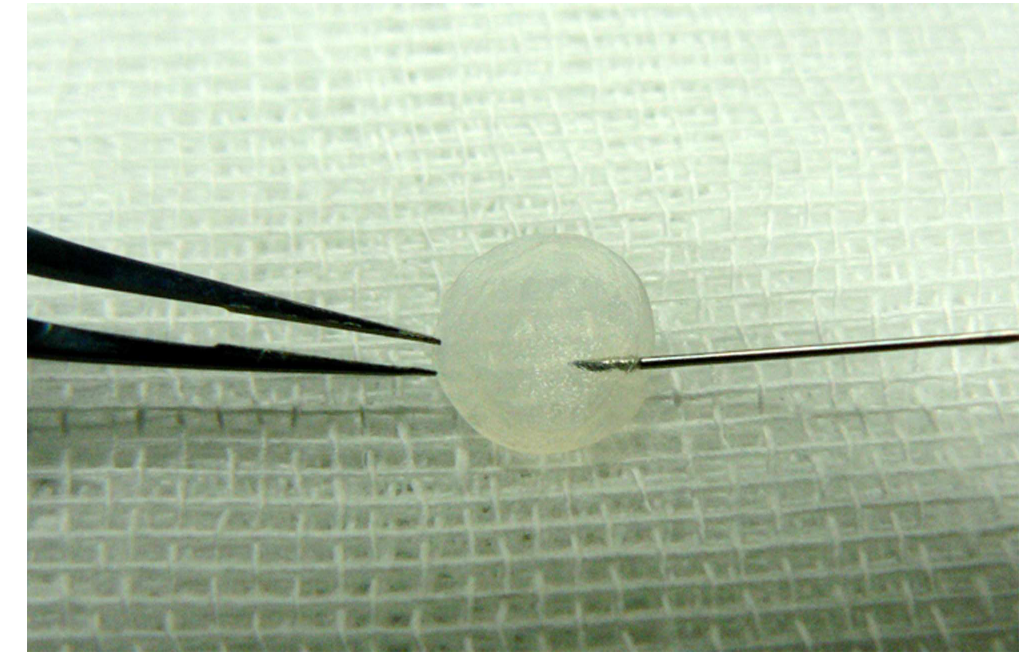
Fig 1. Representative image of stromal cell